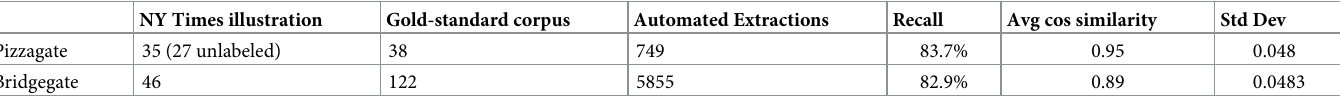
Table 4. Comparison of pipeline inter-actant relationship discovery with the NY Times and the gold standard corpora. NY Times illustration